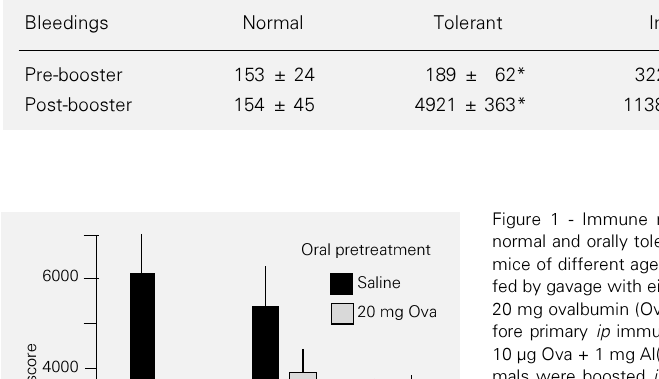
Table 1 - Maintenance of oral tolerance is not affected by aging. B6D2F1 mice were fed either saline (normal and immune group) or 20 mg Ova (tolerant group) by gavage 7 days before the primary immunization and booster. The normal group was not immunized. The animals were classified as normal, tolerant and immune, and then, allowed to rest for 62 weeks before being boosted again with 10 (cid:181)g Ova ip , 10 (cid:181)g Ova + 1 mg Al(OH) 3 and 10 (cid:181)g Ova 7 days apart. Sera were collected 7 days after the last immunization and antibodies were measured by ELISA. ELISA scores and significant differences between tolerant and immune groups were calcu- lated as shown in the legend to Figure 1. *P<0.001 compared to the normal